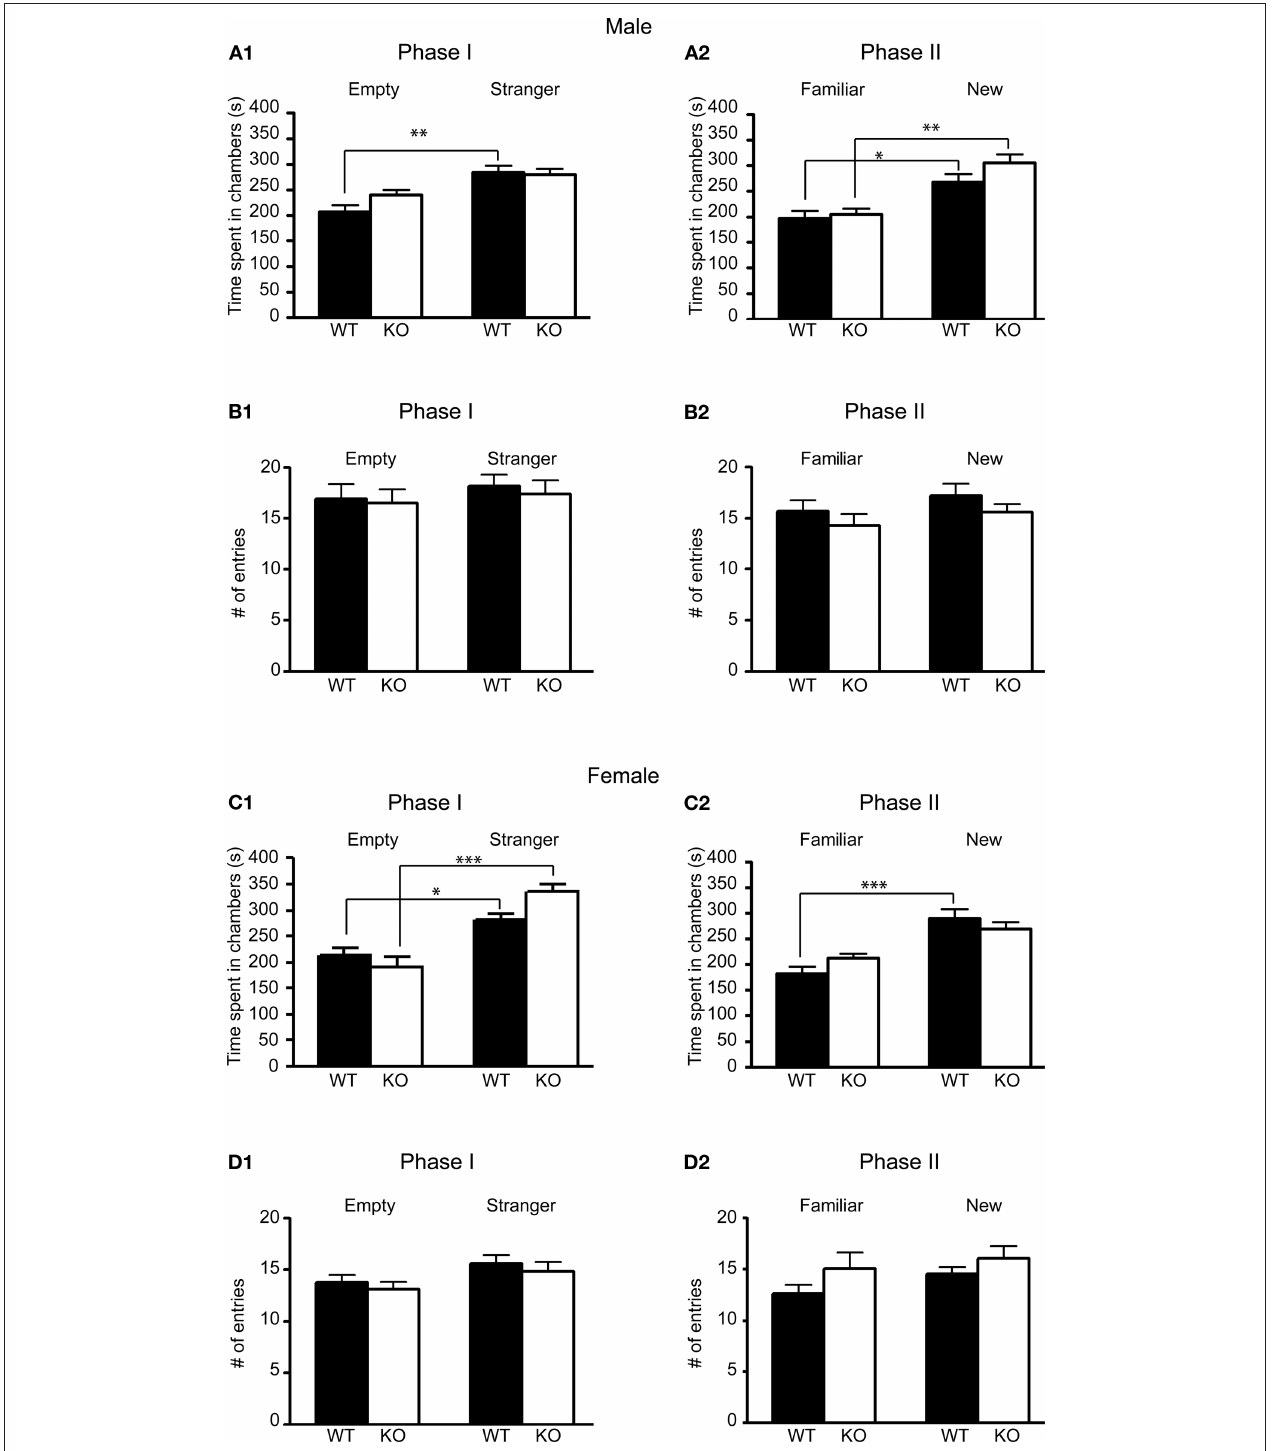
female 5-HT knockout mice spent significantly more time in the chamber Figure 3 | Male and Female 5-HT knockout mice show differences in 3A 3A containing a novel stranger mouse than in the chamber containing the same preference for social novelty in the social approach test. (A1,C1) In the first mouse of the previous experiment similar to wildtype mice. (B,D) During both phase (Phase I) of the social approach test only female and not male 5-HT 3A phases of the test both wildtype and 5-HT knockout mice of both sexes did not knockout mice spent significantly more time in a chamber containing a wildtype 3A visit one of the end chambers more than the other. Data are expressed as the stranger mouse than in a chamber containing an empty cup similar to wildtype mean ± SEM (* p < 0.05, ** p < 0.01, *** p < mice. (A2,C2) In the second phase (Phase II) of the test only male and not